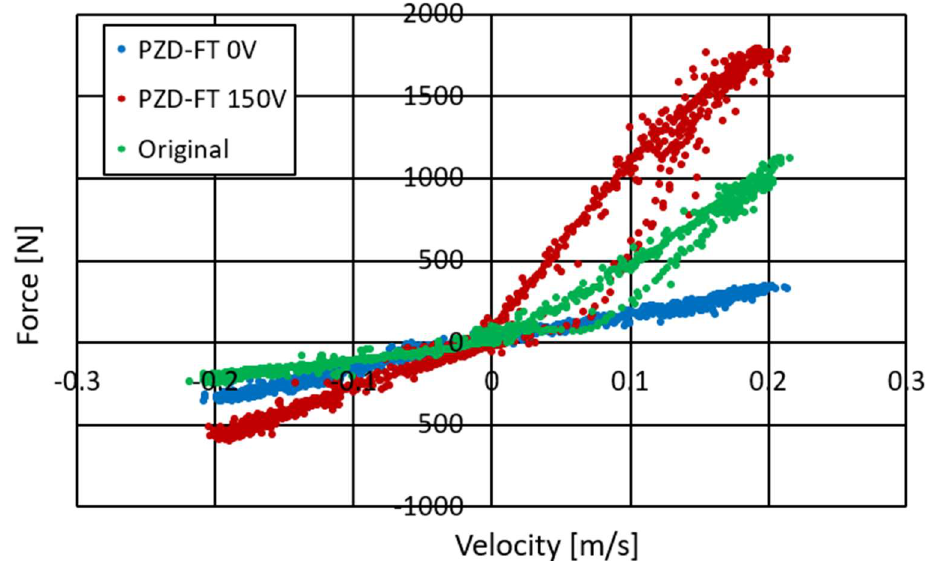
Figure 8. Experimental results of an automotive PZD damper of control in the velocity–force plane, kinematic excitation with a frequency of 1 Hz, amplitude of 0.030 m, voltage of 0–150 V: PZD-FT 0 V (blue)—PZD without supplying voltage (0 V), PZD-FT 150 V (red)—PZD with supplying voltage (150 V), Original (green) factory passive damper.